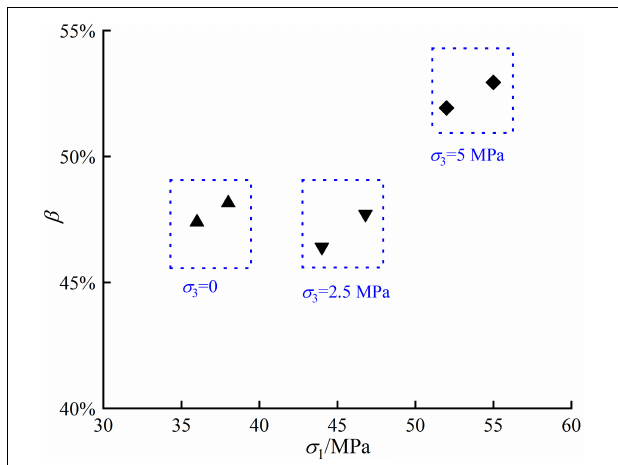
FIGURE 5 | Relationship between β with aixial stresses.